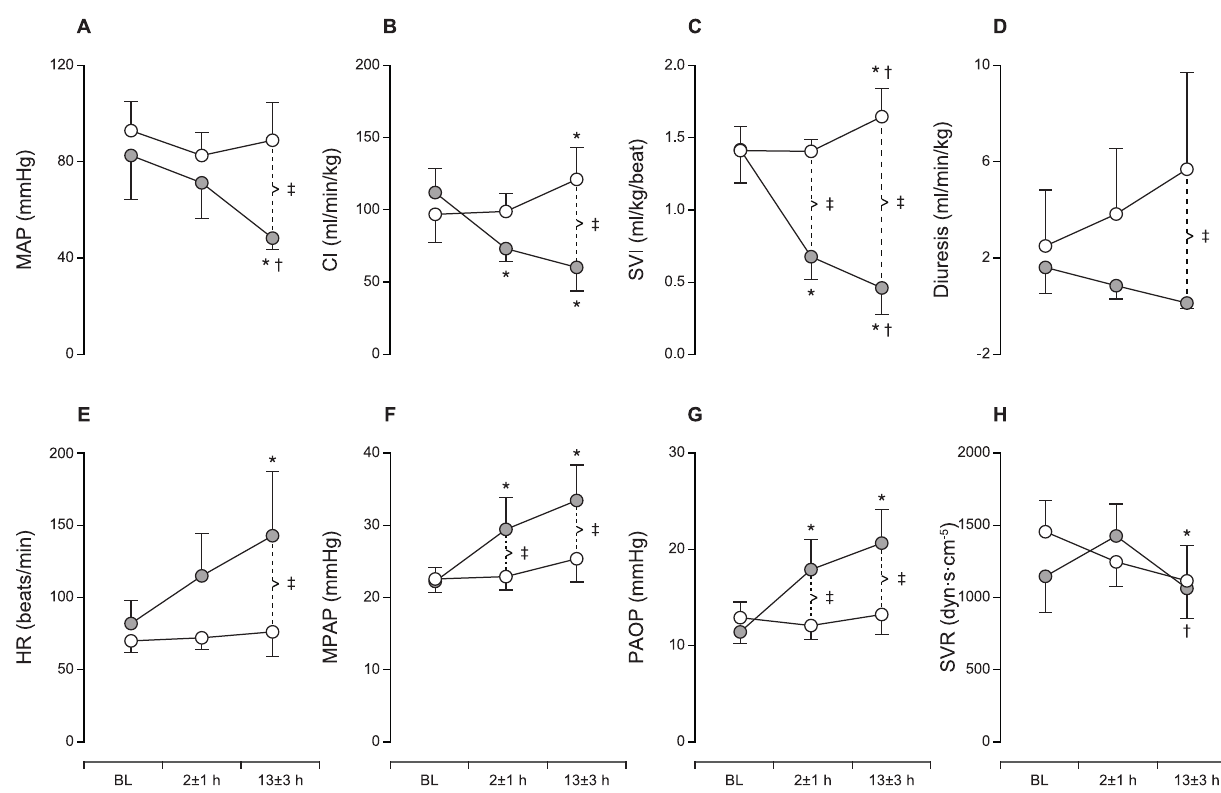
Figure 1. Hemodynamics. A–D: Mean arterial pressure (MAP), cardiac index (CI) and stroke volume index (SVI) decreased following coronary microembolization (CME). Diuresis gradually declined, and all shock-treated animals developed oliguria/anuria. E–F: A profound increase in heart rate (HR) developed after CME. Mean arterial pulmonary pressure (MPAP) and pulmonary artery occlusion pressure (PAOP) both increased after CME due to severe left ventricular dysfunction. The systemic vascular resistance (SVR) was unaffected by CME. The data are presented as mean 6 SD. Open circles, time-matched control group; filled circles, cardiogenic shock group. * p , 0.05 within group compared to baseline, { p , 0.05 within group compared to 2 6 1 hours, ` p , 0.05 between groups.